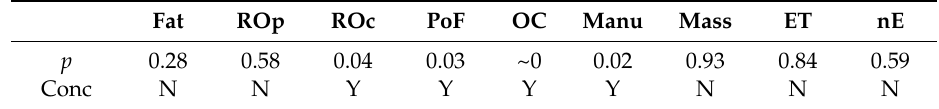
Table 1. Fisher’s exact test, comparing characteristics of accidents with maintenance contributions to all accidents, in the ICAO o ffi cial accident data set. Fat